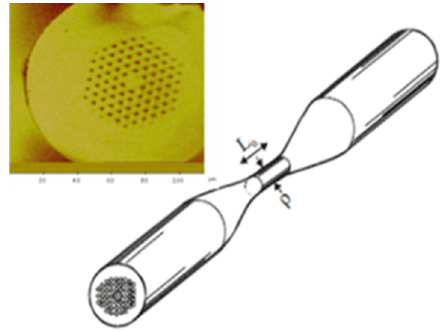
Figure 37. Cross-section of an untapered PCF and illustration of a uniform waist tapered PCF used for refractive index sensing. L 0 is the tapper length and ρ tapper waist diameter (Reproduced from [106], with the permission of OSA publishing).